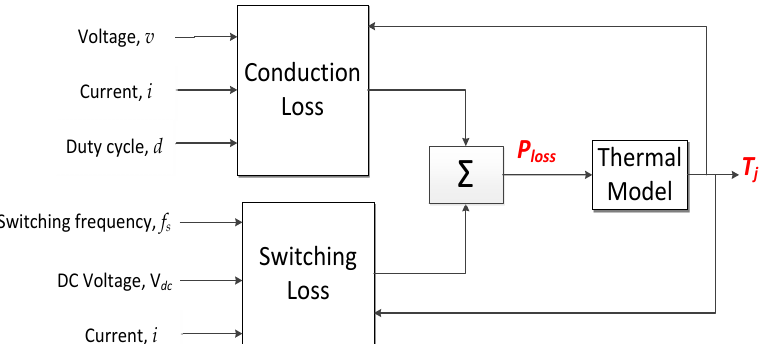
Figure 9. Loss calculation in IGBT and diode. The diagram shows that losses also depend on the junction temperature T j ; hence, the feedback loop from the thermal